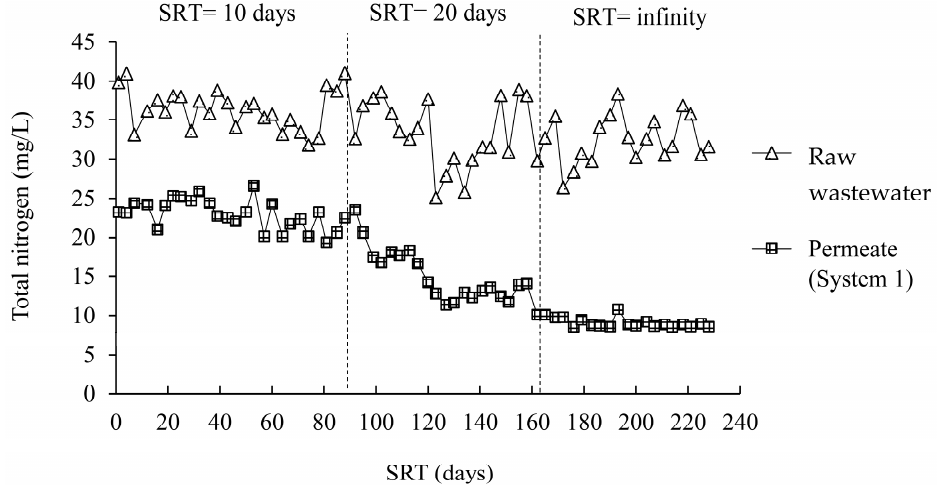
Figure 6. Total nitrogen concentrations during the experiment at different SRTs in the A/O-MBR system (System 1).